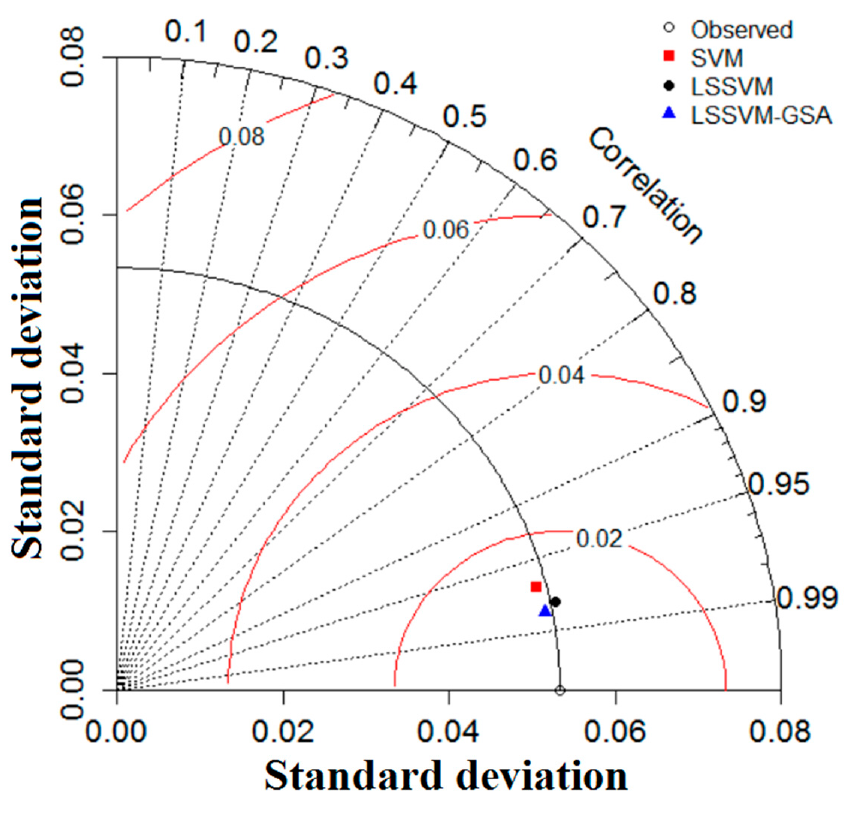
Figure 8. Taylor diagram of the observed and predicted C d by different models.